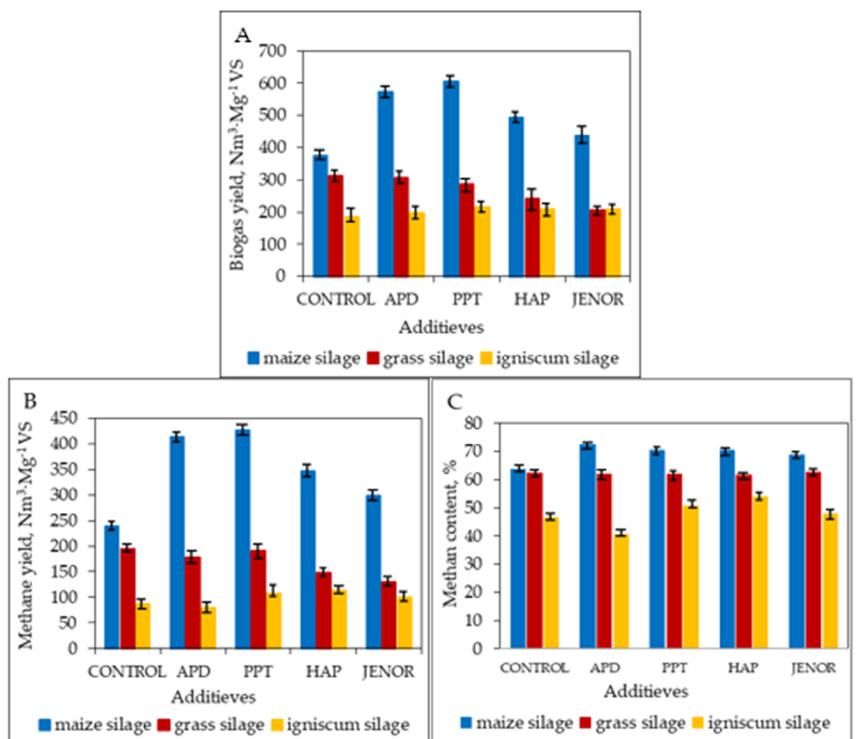
Figure 3. Summary of biogas and methane yields from selected silages using different additives: ( A ) biogas yield, ( B ) methane yield, ( C ) methane content.